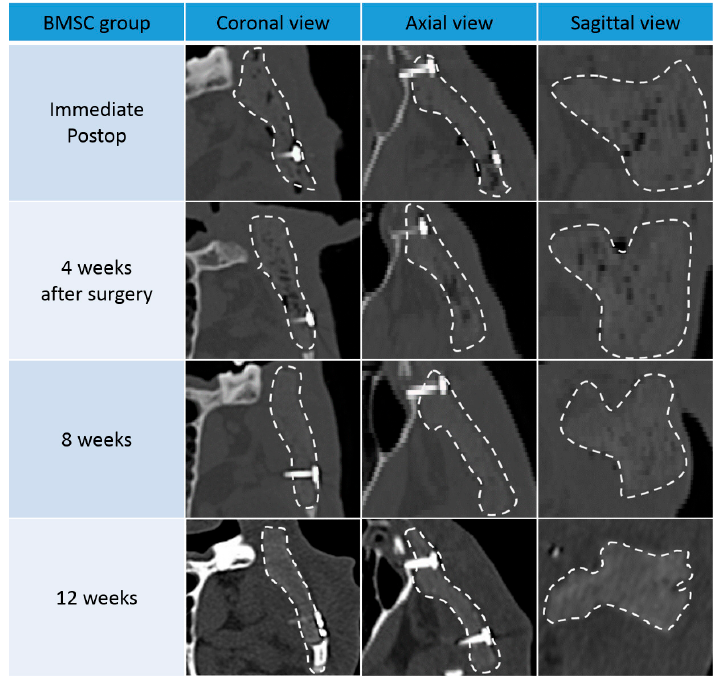
Figure 4. Computed tomography (CT) images of coronal, axial, and sagittal views from the bone marrow stem cell (BMSC) group. Images were acquired directly after surgery and 4, 8, and 12 weeks later.